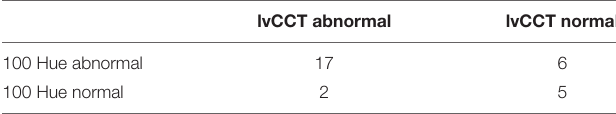
TABLE 2 | Classification of eyes as normal or abnormal when tested with the 100 Hue and Cambridge Color Test (CCT).